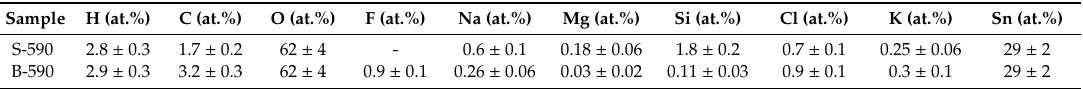
Table 3. Summary of TOF-ERDA elemental analysis (MC simulation). Total atomic content is normalized to